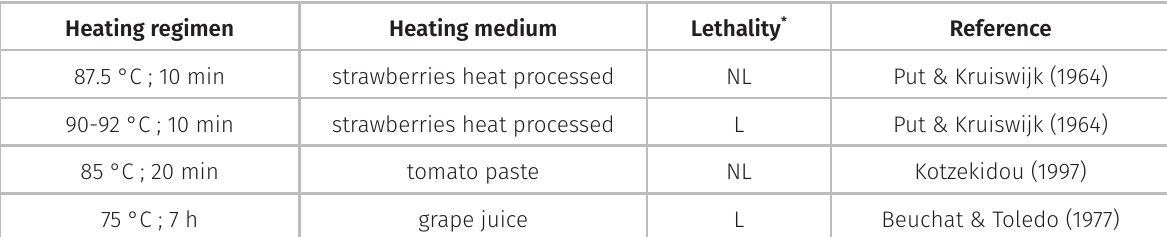
Table III. Thermal resistance of ascospores of Byssochlamys nivea depending on the heating regime in products based on grapes and other